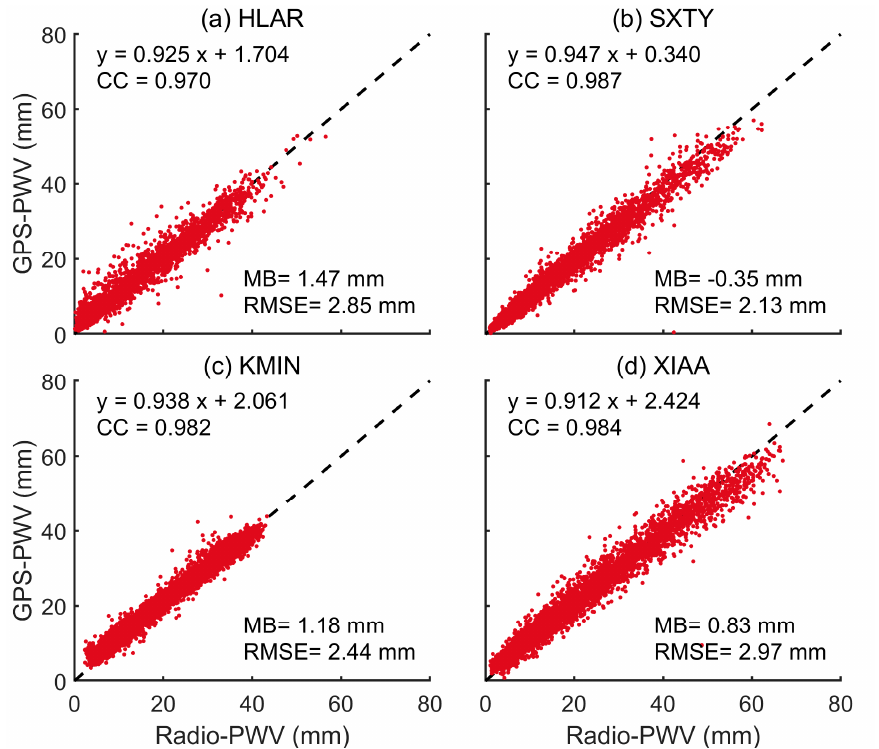
Figure 2. The scatter plots of the GPS-PWV derived from HLAR ( a ), SXTY ( b ), KMIN ( c ), and XIAA ( d ) station versus the Radio-PWV derived from the corresponding adjacent meteorological stations. The CC, MB, and RMSE values of each station are also given in the figure.